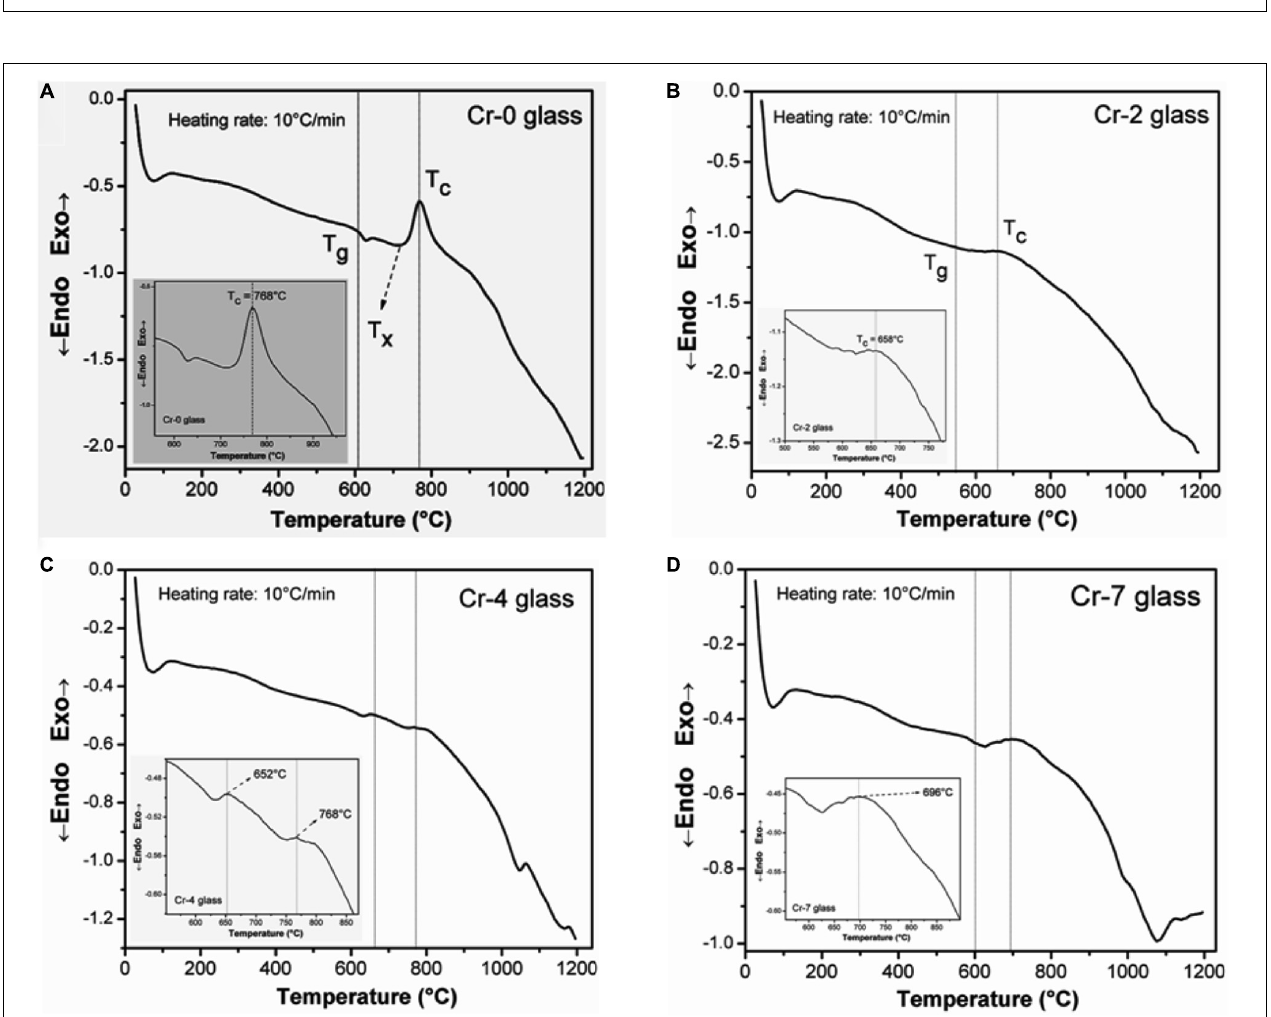
FIGURE 2 | Differential scanning calorimetric (DSC) thermogram of K 2 O-MgO-Al 2 O 3 -B 2 O 3 -SiO 2 -F glasses containing (A) 0 mol%, (B) 2 mol%, (C) 4 mol%, and (D) 7 mol% chromium content, showing the glass transition region (T g ), crystallization onset point (T x ) and crystallization exothermic temperature, T c (for composition see Table 1